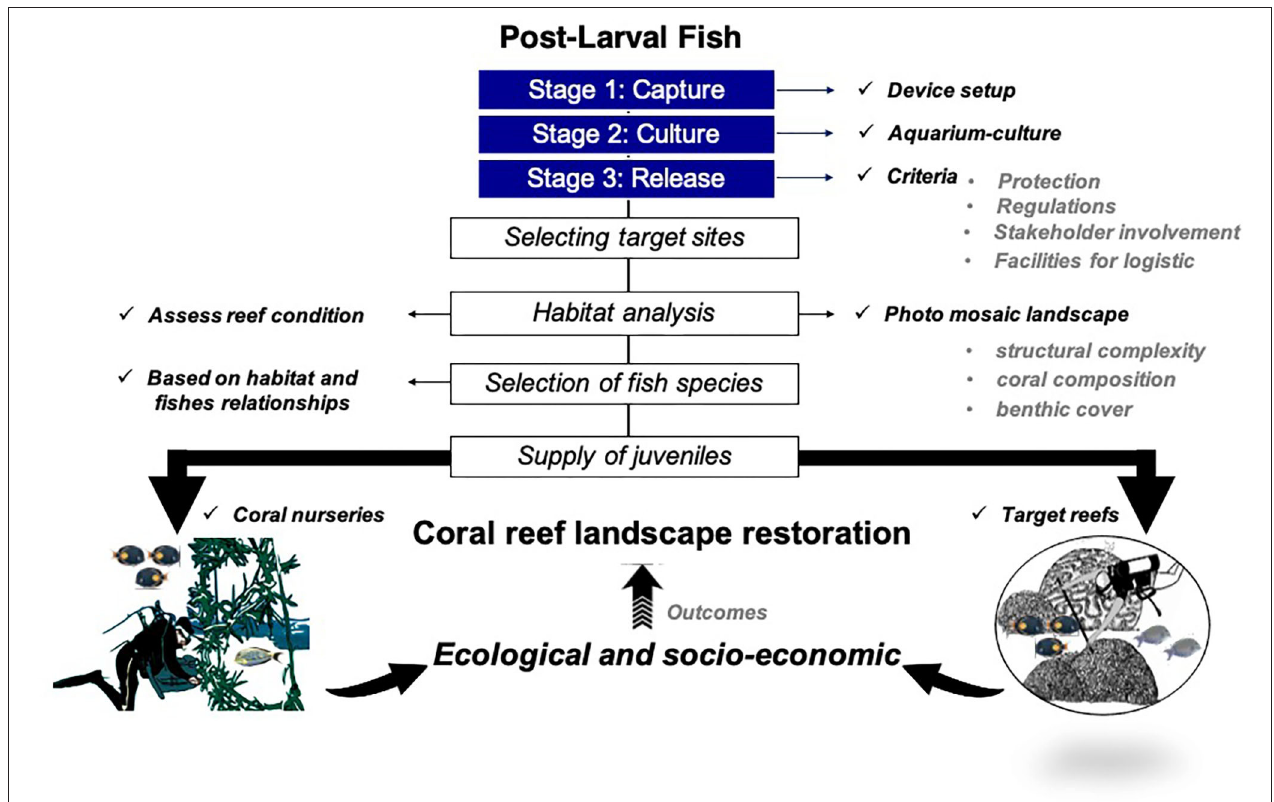
FIGURE 2 | Outline for selecting target sites for release postlarval reef dishes after capture and aquarium